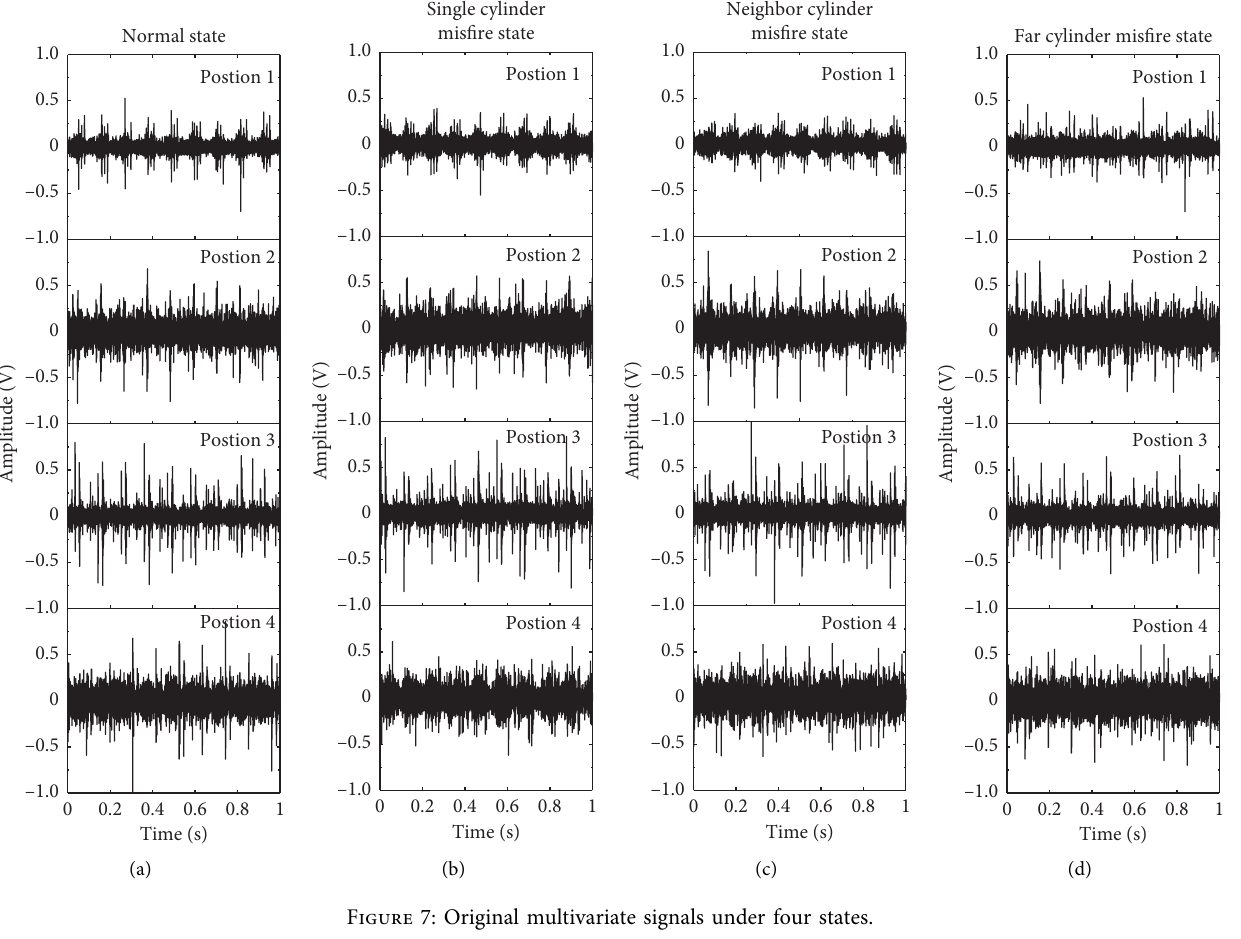
Figure 7: Original multivariate signals under four states.